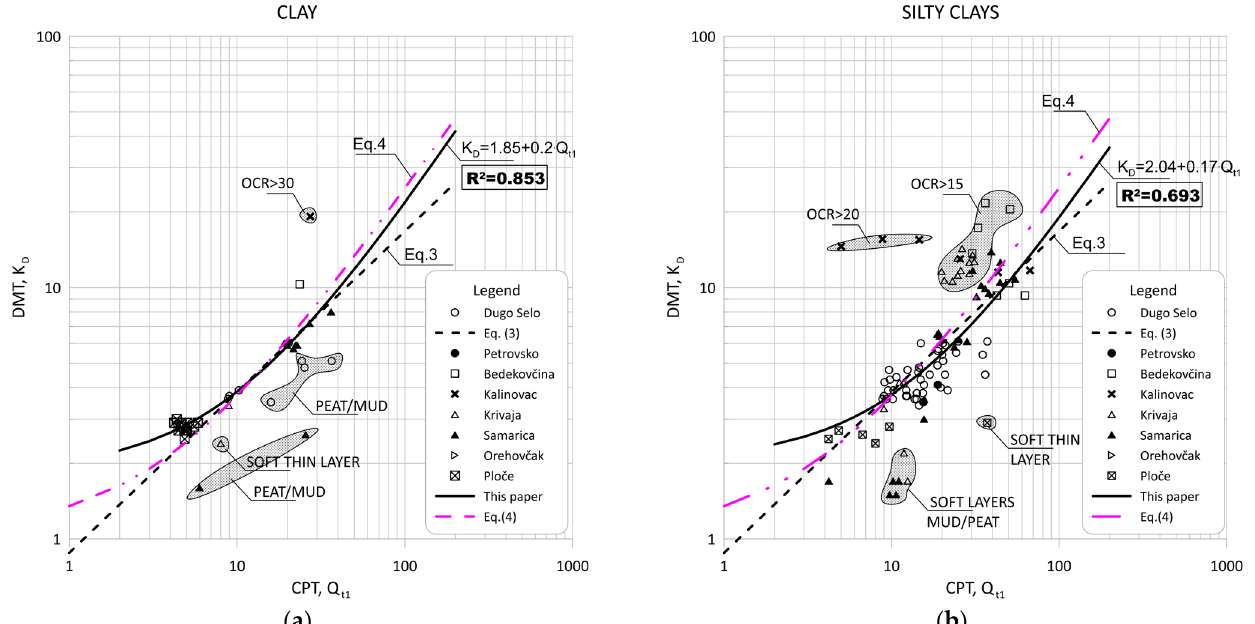
< 0.6, > 2.95) . 𝐼𝐼 𝐷𝐷 𝐼𝐼 𝑐𝑐